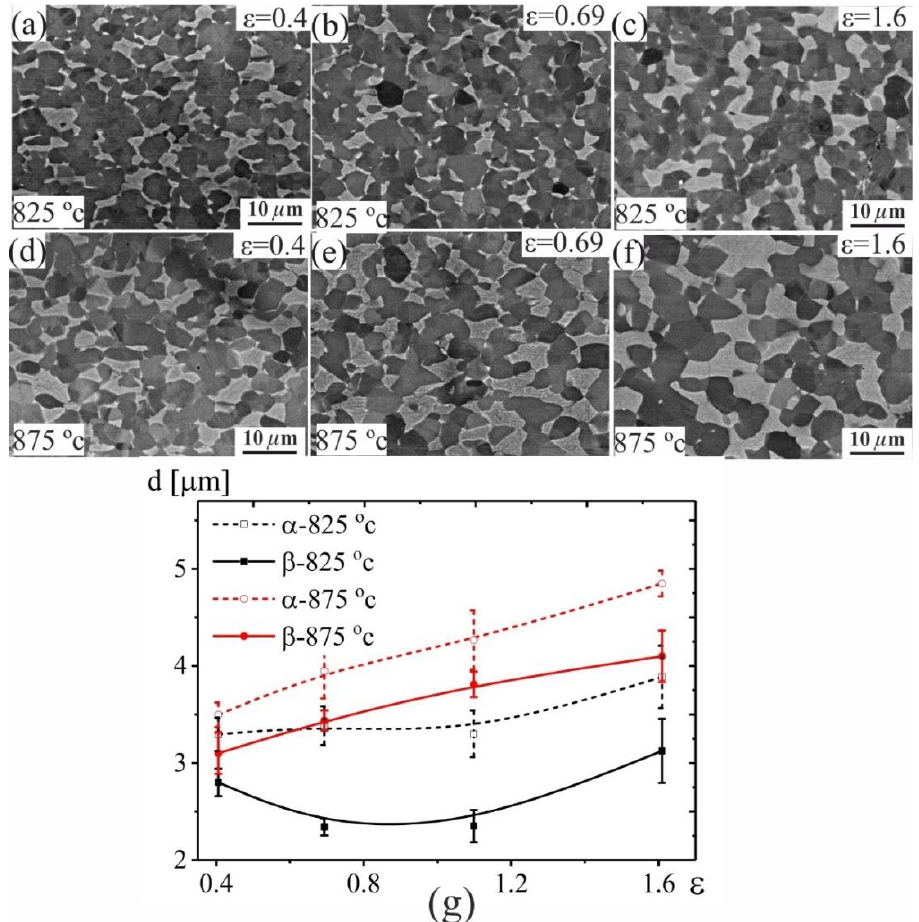
Figure 4. Microstructure evolution after 0.4, 0.69, and 1.6 strain at a temperature of ( a – c ) 825°C, ( d – f ) 875 °C and ( g ) grain sizes-strain dependence. ( d – f ) 875 ◦ C and ( g ) grain sizes-strain